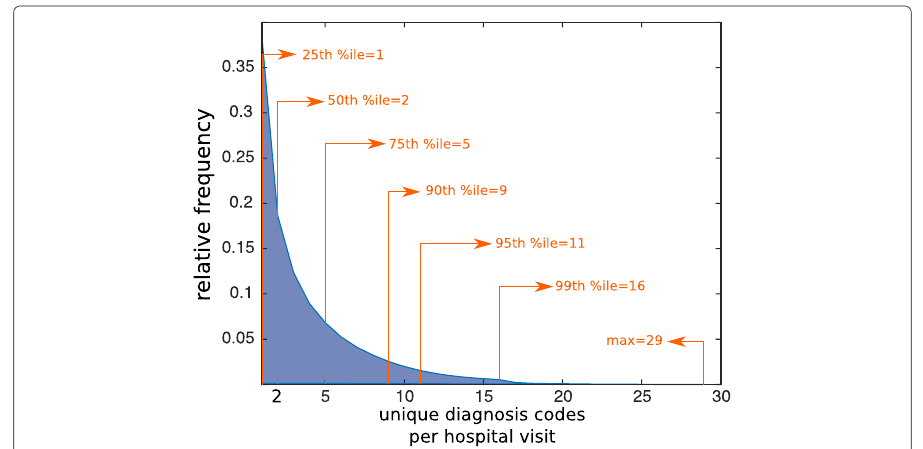
Fig. 1 Hospital visits. The distribution of the number of ICD9-coded diagnosis per hospital visit